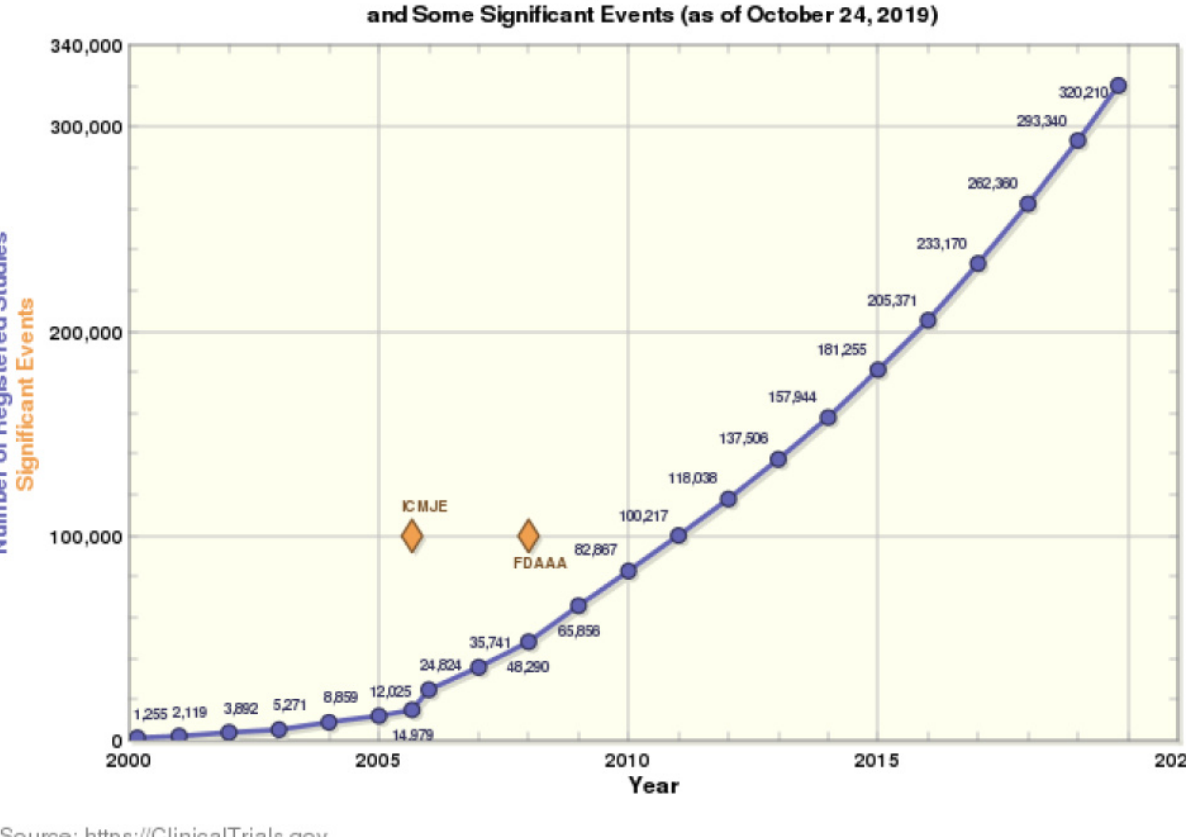
Figure 1. Study registrations on ClinicalTrials.gov show an increasing